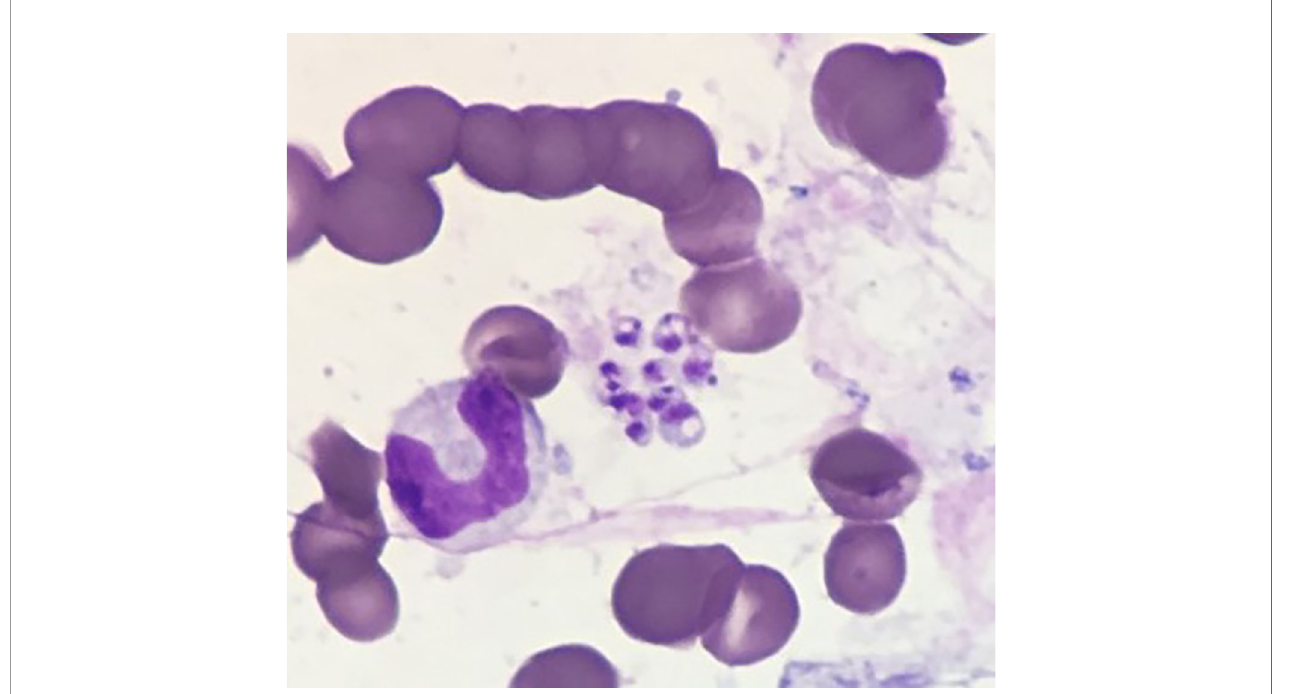
FIGURE 1 | Bone marrow aspirate smear (from bone marrow biopsy) stained with May-Grünwald Giemsa showing amastigote forms of Leishmania